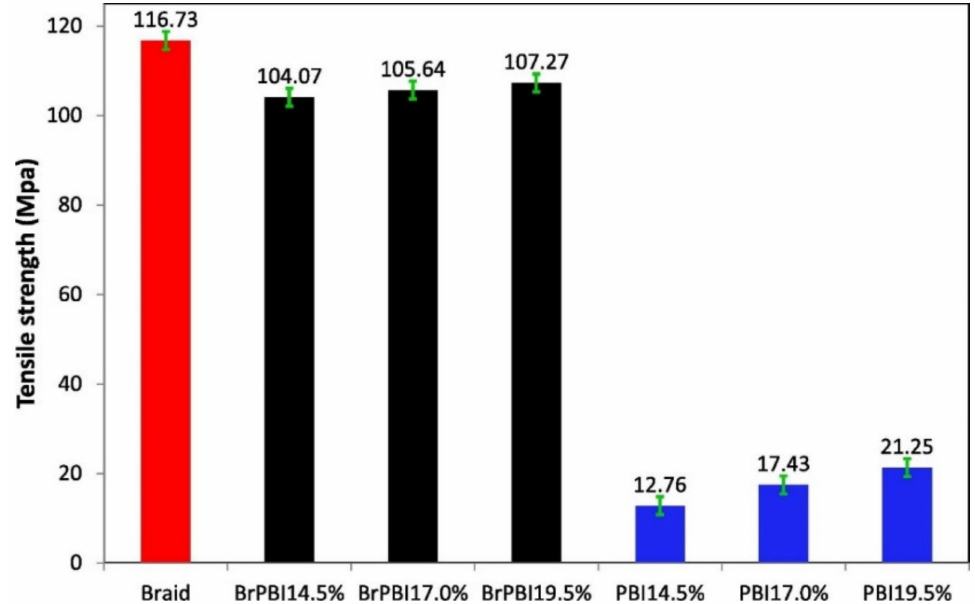
Figure 10. A comparison of tensile strength between braid-reinforced and self-support PBI hollow fibers. Reprinted with permission from Ref. [19]. Copyright 2022,